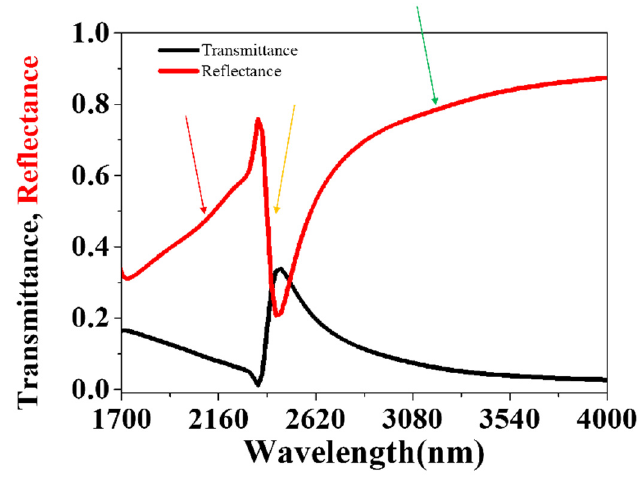
Figure 2. The simulated transmittance and reflectance curves of the fishnet metamaterial with circular holes. The red arrow points out the location of magnetic resonance at 2072 nm, the yellow arrow points out the location of electric resonance at 2300 nm, the green arrow points out the location of magnetic resonance at 3225 nm.